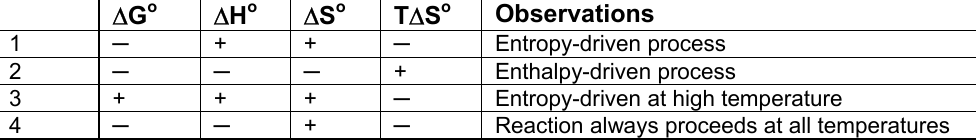
∆ G o ∆ H o ∆ S o T ∆ S o